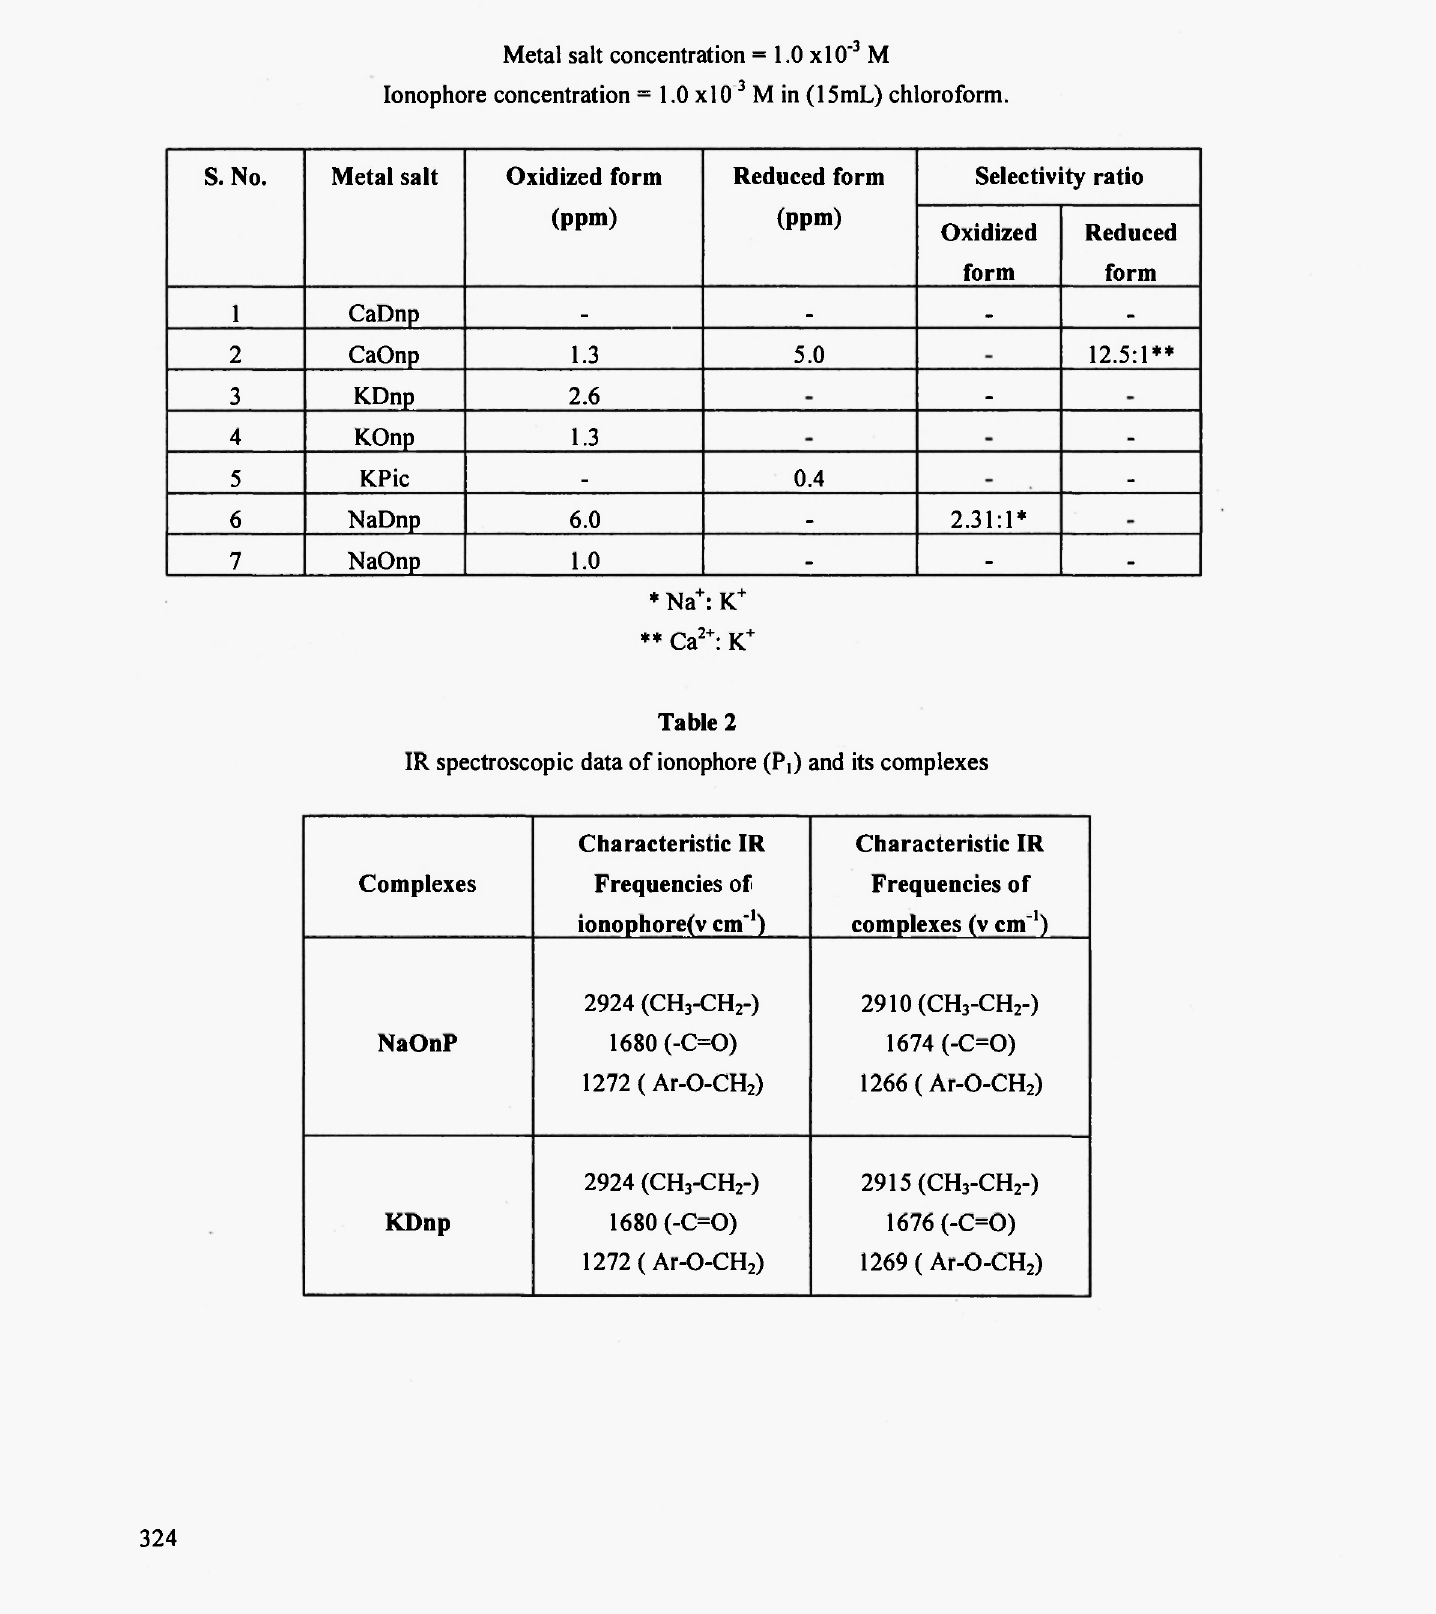
Amount of metal cations extracted with redox-switched ionophore (Pi) in